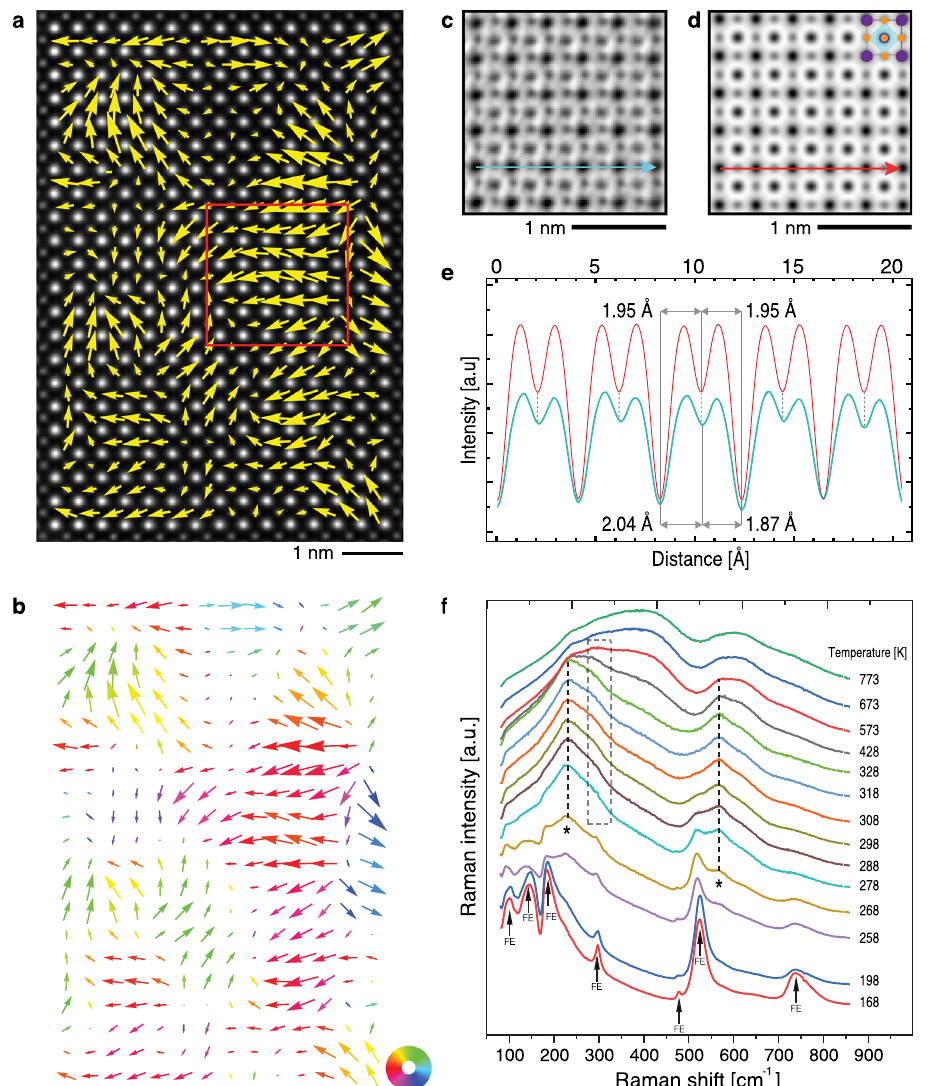
Fig. 1 Evidence of polar nanoclusters in cubic BST6040. a HAADF image of a 14 × 21 unit-cell area viewed along the [0 0 1] pc zone axis. The bright spots correspond to the (Ba,Sr) columns (A site) and smaller, paler spots to the Ti columns (B site). Arrows show displacement of B-site atoms measured as the deviation of the experimental position of B sites from the centre of the four neighbouring experimental A-site positions (see Supplementary Note 2). The length and orientation of arrows indicate magnitude and angle of the relative displacement of Ti from the ideal position. b The same as in a with the colour of arrows indicating regions of coherent displacements, highlighting different nanoclusters. c Experimental ABF image from the region marked by the red rectangle in a . d Simulated ABF image of cubic BST6040. e Intensity pro fi les along the arrows shown in c , d : cyan, experimental ABF image; red, simulated ABF image with cubic phase. Displacement of oxygen atoms from the ideal cubic sites is visible in the cyan pro fi le. f Raman spectra of BST6040 as a function of temperature. The modes marked by arrows are characteristic of the ferroelectric (FE) phase and those marked by asterisks indicate broken translational symmetry caused, on the short range, by lattice defects (i.e. Sr 2 + substitution). The fi rst-order phonon mode at 300 cm − 1 (enclosed by the dashed square) indicates that the ferroelectric-like distortion is present on the short-range scale well within the paraelectric phase (above T C = 273 K). The presence of polar and disorder-activated modes up to 573 K indicates that transition to purely dynamic disorder is attained only above this temperature (see text for